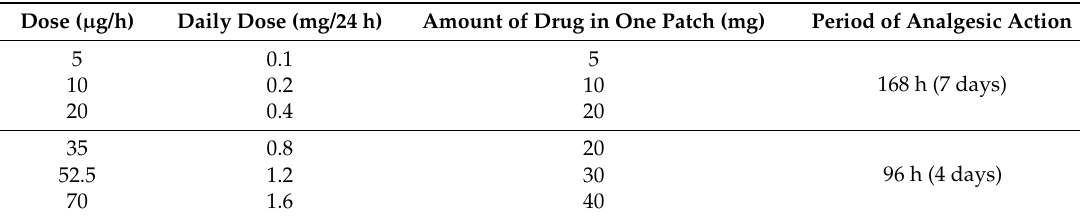
Table 3. Basic data of transdermal buprenorphine